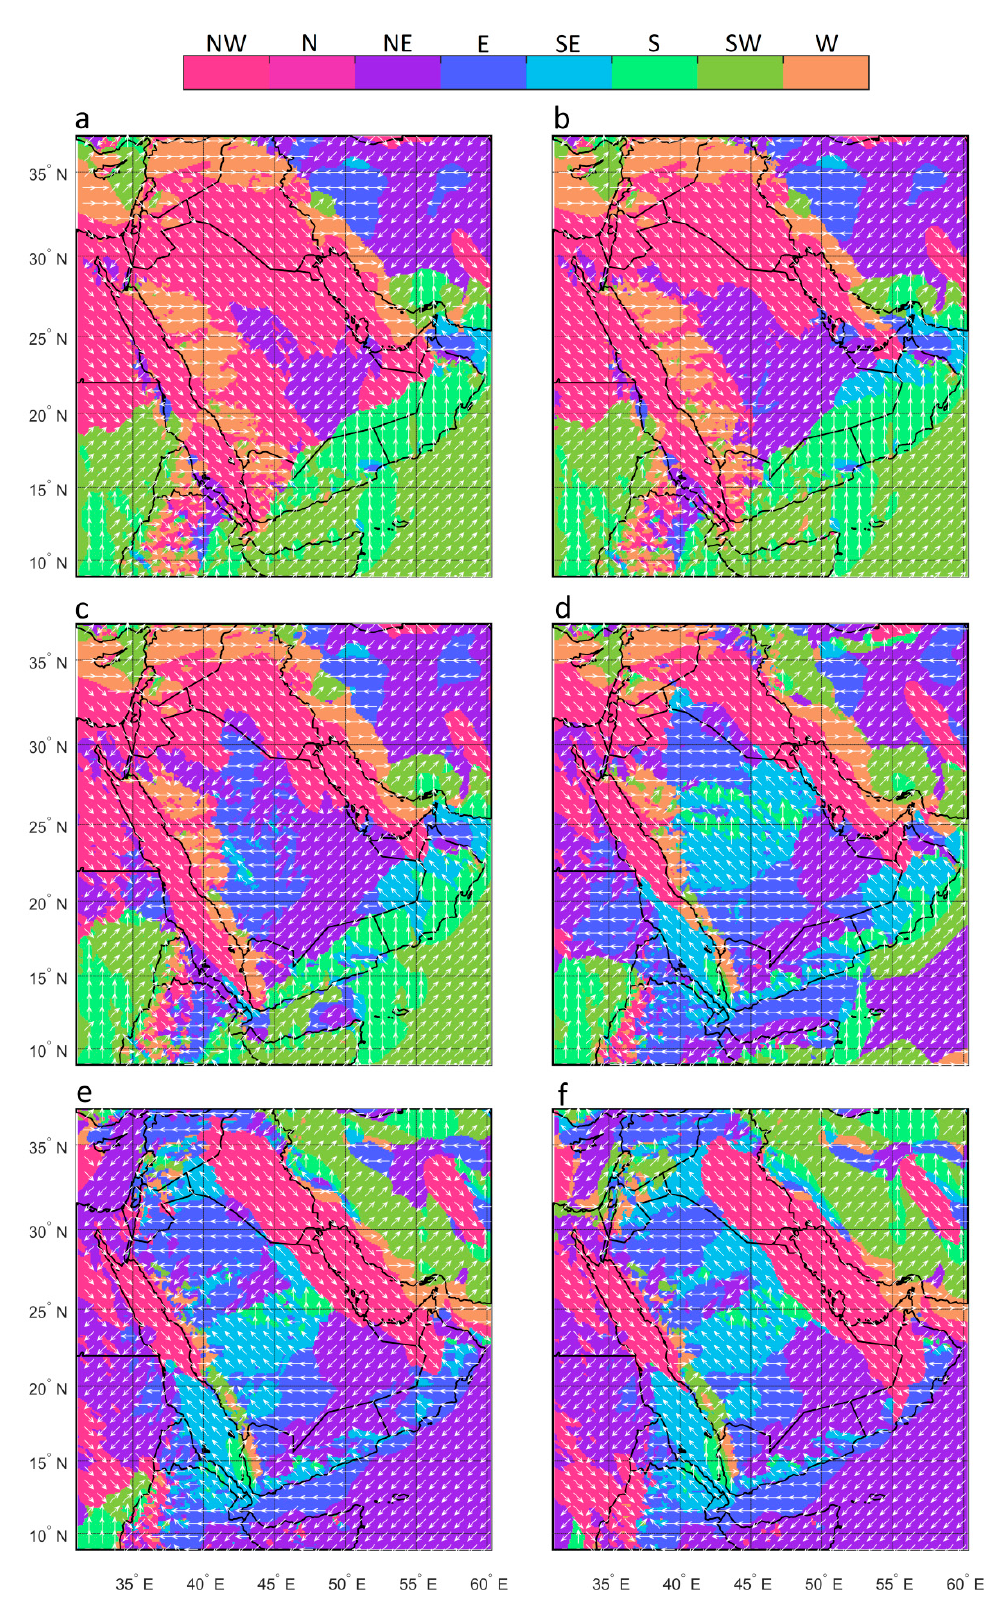
Figure 14. Prevailing wind speed directions from July to December ( a – f ). The spatial distribution of the mean annual wind speed showed that weak winds of 2–3 m / s prevailed over the whole region (Figure 12a). The highest values (of 3 m / s) were observed along